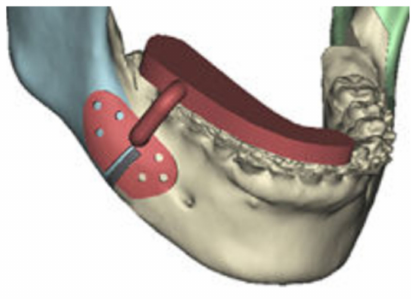
Figure 2. Use of computer-aided surgical simulation in BSSO [35]. Reprinted/adapted with permis- sion from Ref. [35]. Copyright 2017,